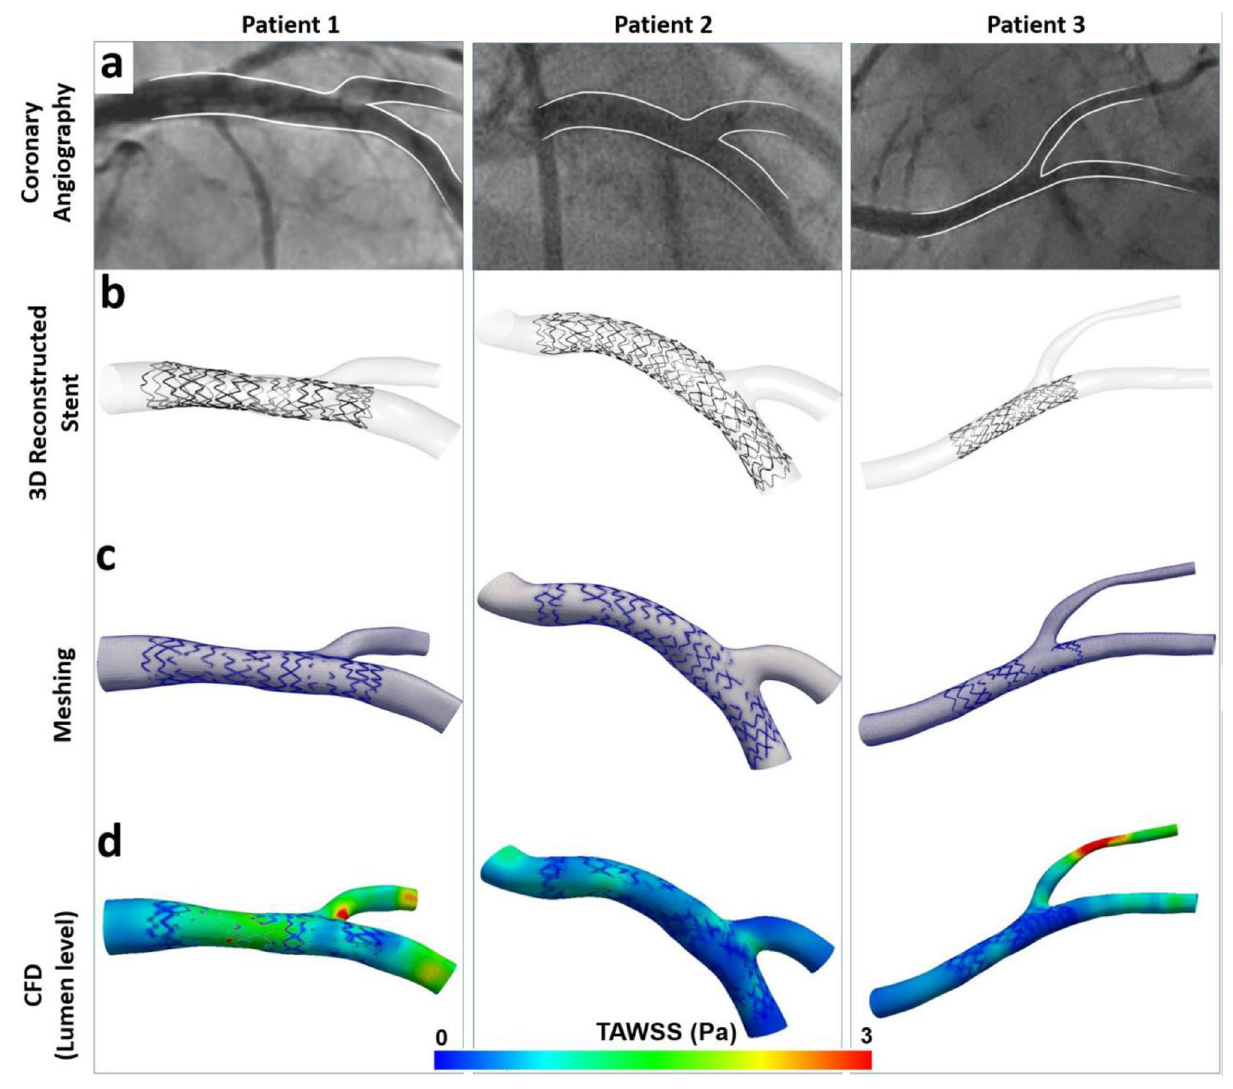
Figure 7. Clinical feasibility of the proposed 3D stent reconstruction method. (a) Invasive coronary angiography post stenting, (b) 3D lumen and stent reconstruction. Note the qualitative agreement to angiography, (c) meshing of a fluid domain in the stented lumen, (d) computational fluid dynamics (CFD) analysis depicting the time-averaged wall shear stress (TAWSS, Pa) along the stented bifurcations.